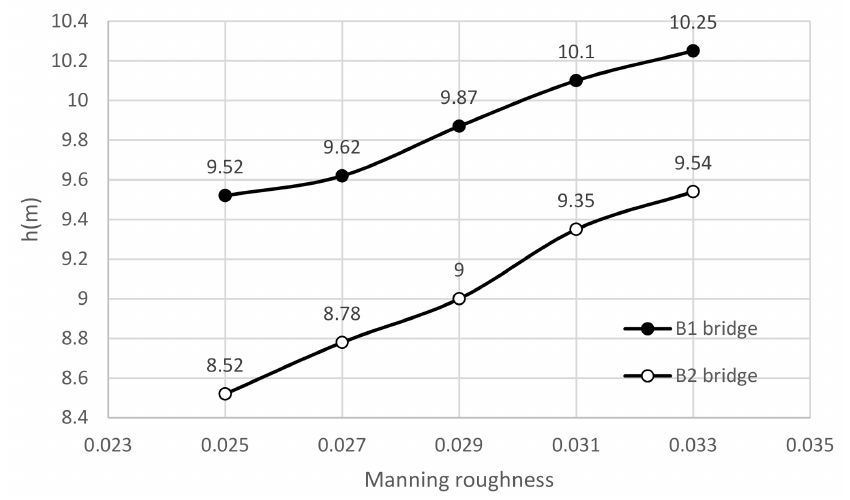
Figure 14. Maximum depths of flood flow versus Manning